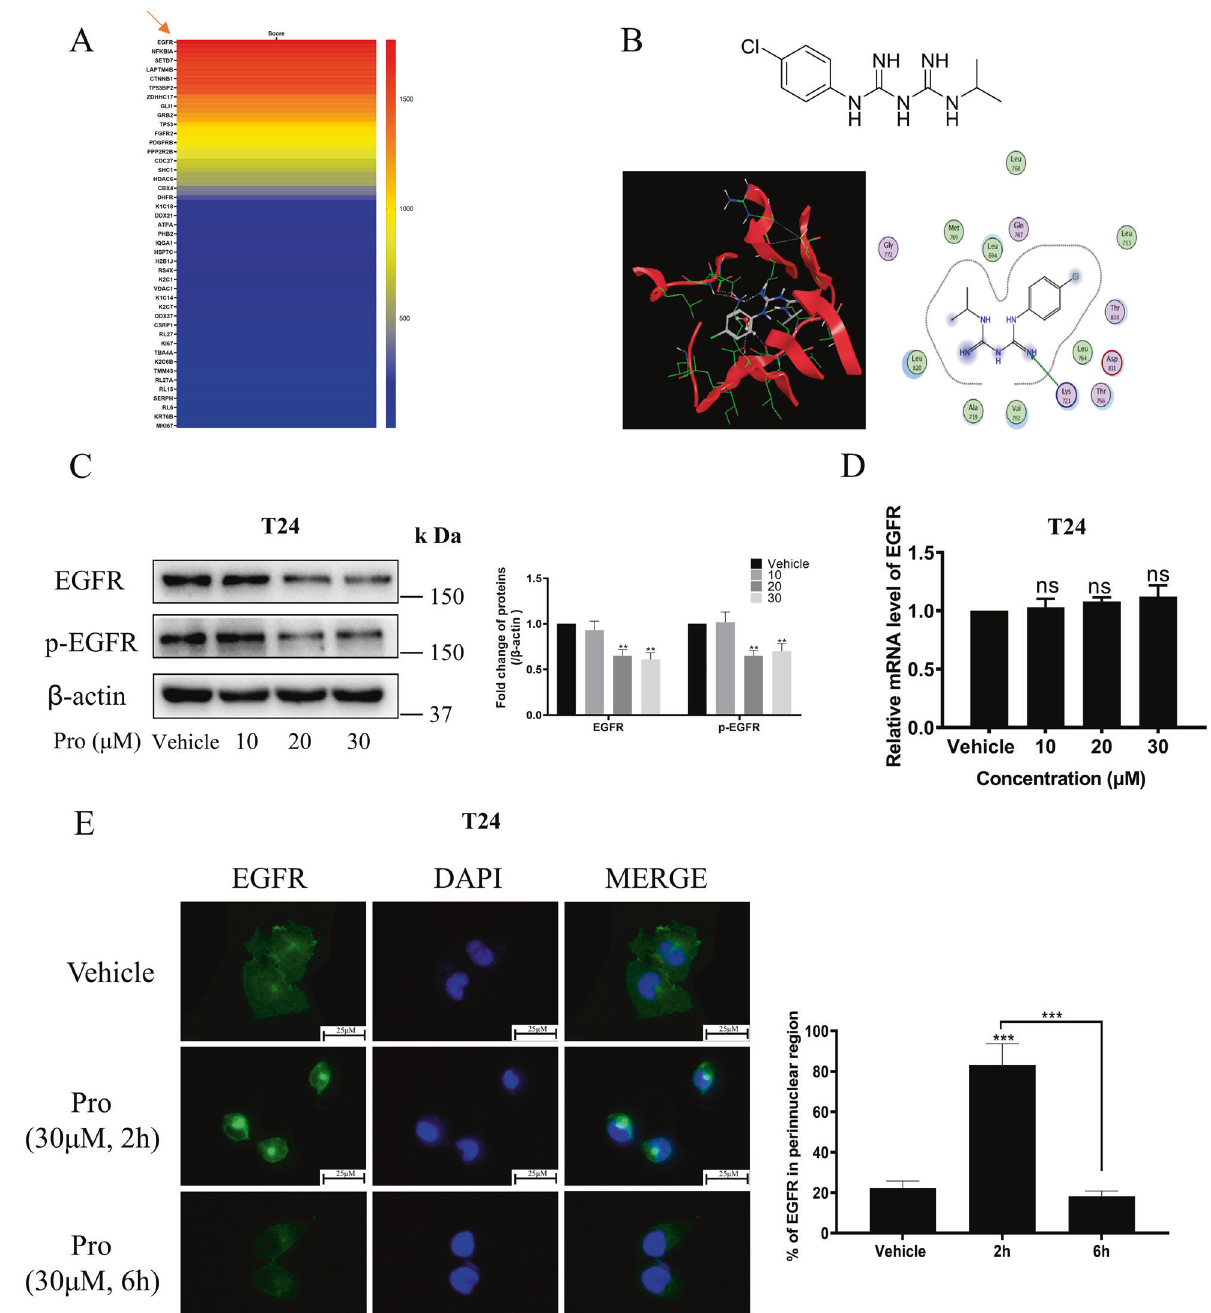
Fig. 1 The effect of proguanil on the expression of EGFR. A 3D photocrosslinked microarray was used to immobilize proguanil, and then T24 lysates were distributed on the surface of the microarray. The captured target proteins by proguanil on the microarray surface were detected by SPRi and identi fi ed by LC-MS. B MOE molecular docking (using MOE14.0 software) was used to predict the binding site of proguanil and EGFR (PDB ID − 4HJO). C T24 were plated in 6-well plates (3.0 × 10 5 /well). When the cell density reaches 70 – 80%, cells were starved for 12 h and then treated with proguanil for 6 h, and the expression of p-EGFR and EGFR was detected by WB. D T24 were plated in 6-well plates (3.0 × 10 5 /well). When the cell density reaches 70 – 80%, cells were starved for 12 h and then treated with proguanil for 6 h, and the expression level of EGFR mRNA was detected by RT-PCR. E T24 were plated on glass disks in 12-well plates (2.0 × 10 4 /well). After 24 h, T24 cells were starved for 12 h and then treated with proguanil, and the changes of EGFR were detected by immuno fl uorescence. Data are representative of three independent experiments. Error bars represent means ± SD from triplicate experiments. Vehicle control means the concentration of DMSO lower than 0.3% (* P < 0.05, ** P < 0.01, *** P < 0.001, ns not signi fi cant). pathway, thereby inducing autophagy to block the prolifera- role of promoting EGFR endocytosis and degradation. In the tion of BC cells. Hence, our fi ndings would strongly establish current study, we found that proguanil speci fi cally bound to the solid foundation for the potential clinical application of EGFR, enhanced EGFR endocytosis through NCE and degrada- proguanil in BC. tion in lysosome, then inhibited its downstream signaling Cell Death and Disease (2022)